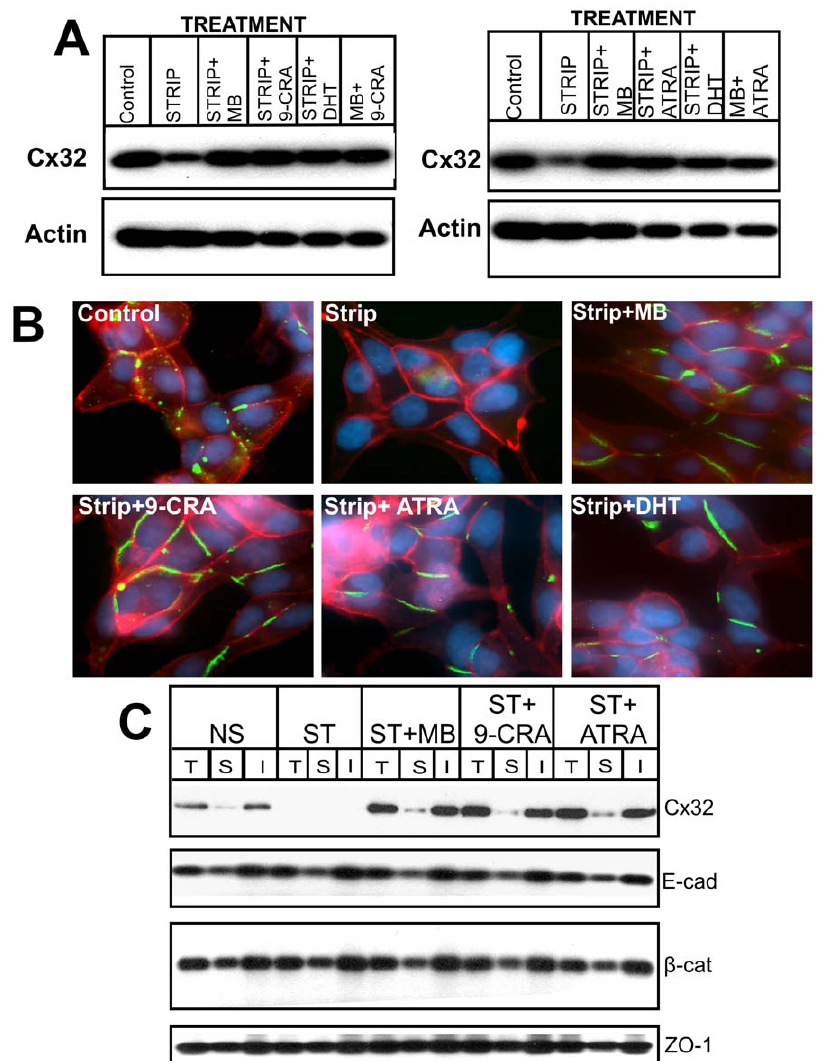
Figure 3. Retinoids block androgen-regulated formation and degradation of gap junctions. LNCaP-32 cells, grown to 70% confluence either in six well clusters or 10-cm dishes, were switched to charcoal-stripped, androgen-depleted (Strip) medium. Expression level of Cx32 and formation of GJs were analyzed by Western blot ( A ) and immunocytochemical analysis ( B ) after 48 h in the presence and absence of 9-CRA and ATRA (1 m M) and MB (2.5 nM) and DHT (10 nM). C . Formation of GJs was also analyzed by Western blot analysis of total, detergent-soluble and -insoluble fractions as described in Materials and Methods. Note that Cx32 and GJs are degraded in androgen-depleted medium and degradation is blocked upon replenishment with 9-CRA, ATRA, MB and DHT. Note also that only the expression level of Cx32 and its detergent solubility changed significantly whereas that of E-cadhiern (E-cad), b -catenin ( b -cat) and ZO-1 was not significantly affected. In (B), the nuclei (green) were stained with DAPI. In A, 10 m g of total protein was